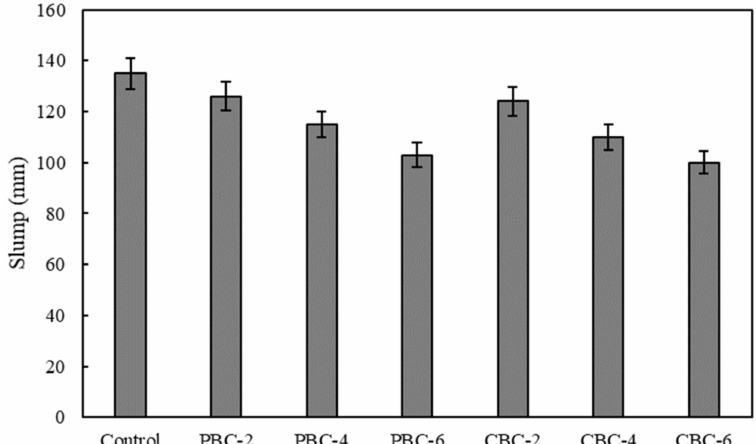
Figure 6. Results of the slump for evaluating the workability of the concrete